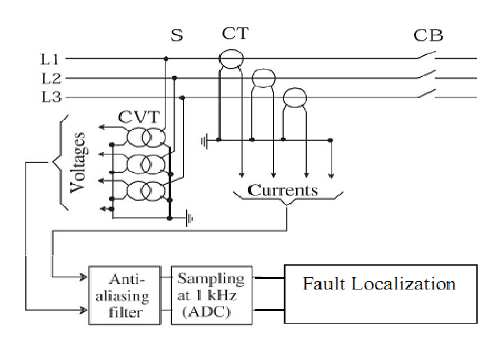
Fig. 3: The steps performed by the digital relay S for fault